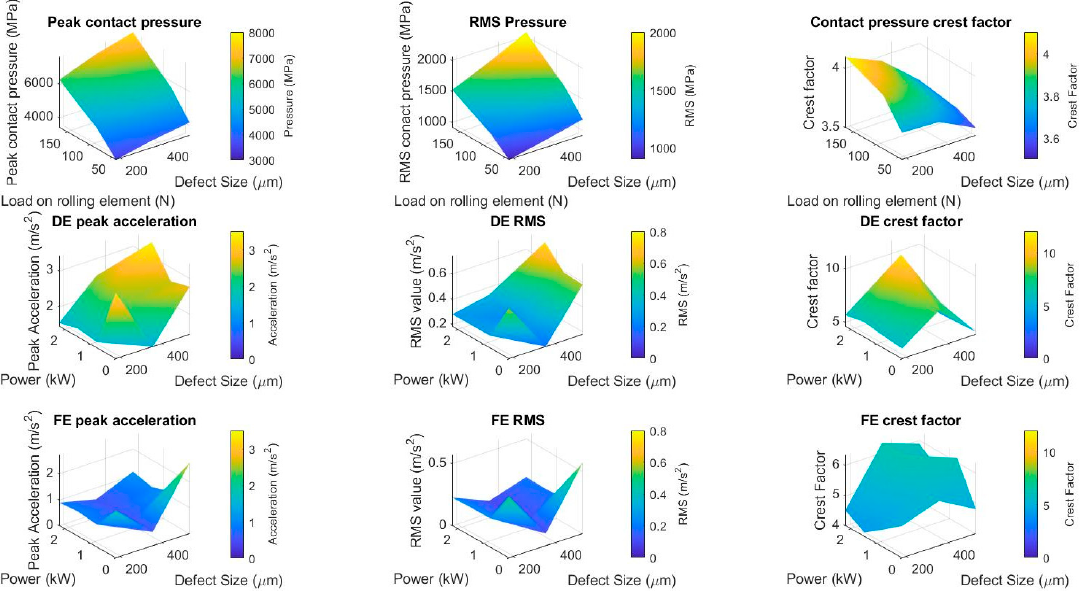
Figure 13. Time features analysis for contact pressure, DE and FE signals.